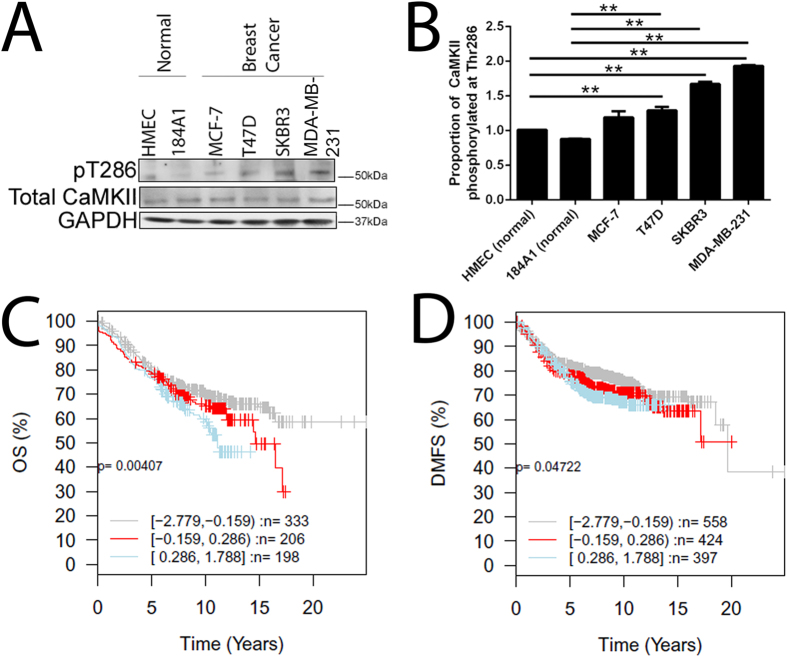
CaMKII phosphorylation at T286 is associated with more aggressive breast cancer, and high CAMK2 expression predicts worse overall and distant metastasis free survival in breast cancer patients.(A) Total endogenous CaMKII and T286 phosphorylation was determined by western blot. GAPDH expression was used as a loading control. Blots are representative of three independent experiments. (B) The proportion of CaMKII phosphorylated at T286 was determined by normalising the level of T286 phosphorylation to total CaMKII expression. **denotes statistical significance p < 0.01, as determined by one-way ANOVA. (C) Kaplan-Meier curves showing the overall survival [OS] and (D) distant metastasis free survival [DMFS] in a publically available 1881-sample breast cancer data set25, with high (blue), mid (red) or low (grey) expression of the CAMK2 family in breast cancer tumours when assessing all tumour subtypes together. P values were computed by a likelihood-ratio test.